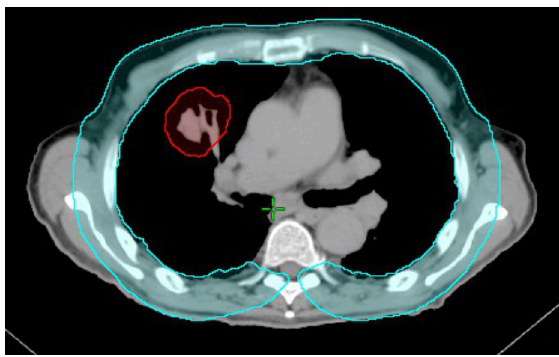
Figure 1. Chest wall and planning target volume (PTV) contour, in blue and red